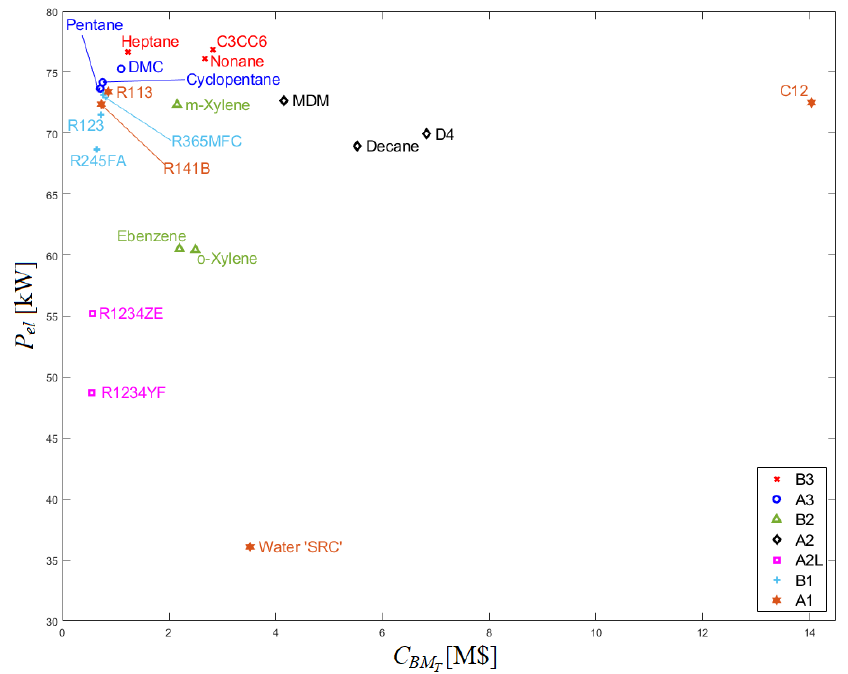
Figure 6. Net output power versus plant cost of the best 3 fluids of each safety category in the case of water thermal